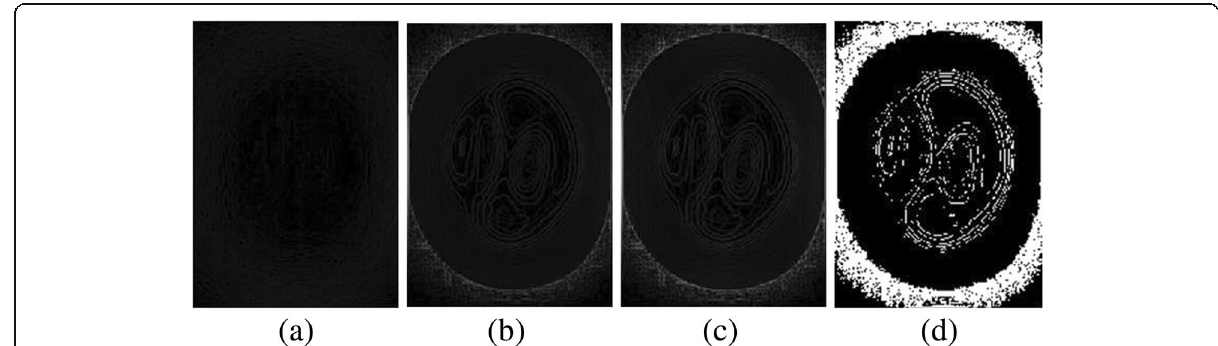
Fig. 8 The edge detection image of original image and the preprocessed image. ( a ) is the prewitt operator detection image of the original image, ( b ) ( c ) is the image detected by the prewitt operator and sobel operator, respectively. ( d ) is the edge detection of the preprocessed image by the gradient threshold method